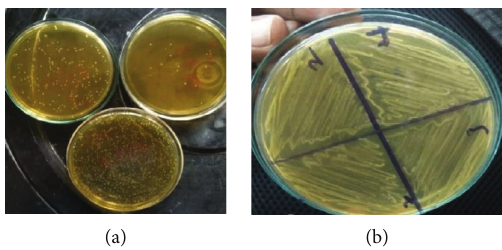
Figure 1: (a) Lactic acid bacteria on MRS agar; (b) LAB after puri fi cation on MRS agar. Table 1: Morphological characteristics of LAB isolated from Ergo samples, Jimma town, southwest Ethiopia. S. no